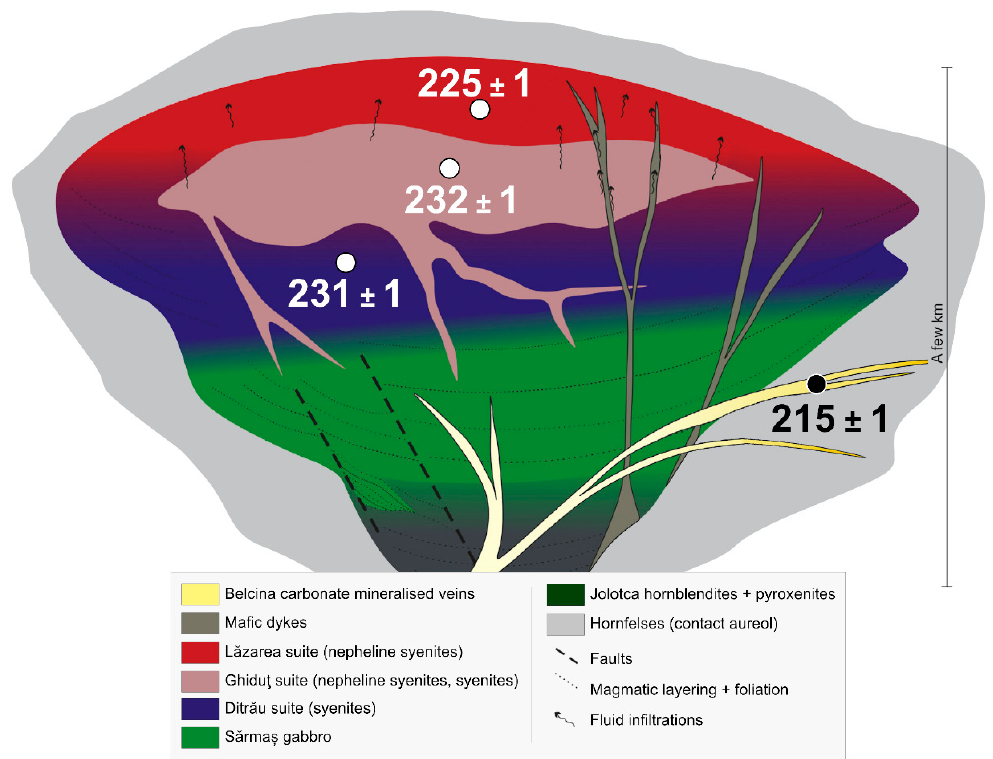
Figure 9. Schematic conceptual model of the Ditr ă u Alkaline Massif (modified from [17]) showing the inferred mean intrusion ages for the Ghidu¸t suite (this work and [6]), the L ă zarea suite (this work and [6]), the Ditr ă u syenite [6,31], and the Belcina carbonate mineralized veins [56]. Color coding follows Figure 1.